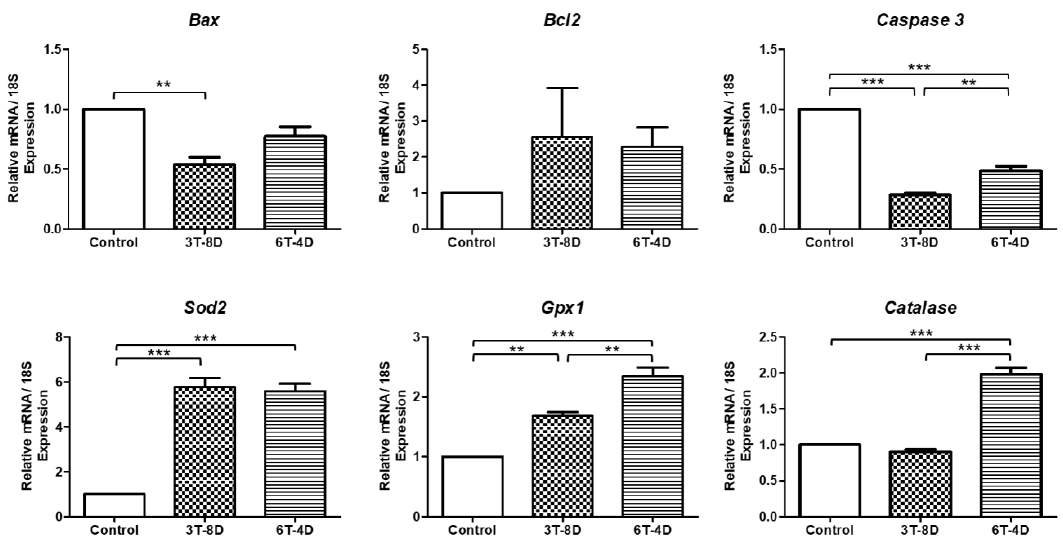
Figure 5. Relative expression to 18S of apoptosis and oxidative stress-related genes from the ovary of the control and groups of human adipose-derived stem cell conditioned medium (ASC-CM) intravenous injection to 4-month-old ICR mice. Data are expressed as the mean ± standard error of the mean (SEM). ** p < 0.01, *** p < 0.001. 4D-6T, six times injection in four day intervals; 8D-3T, three times injection in eight day intervals. Animals 2020 , 10 , x FOR PEER REVIEW